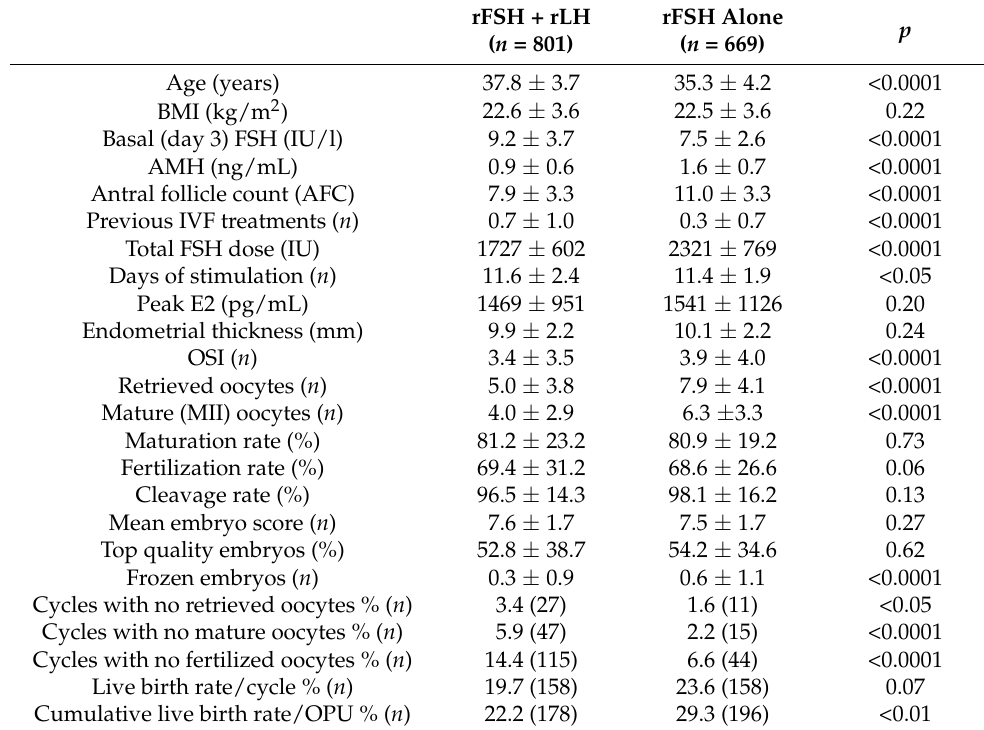
Table 1. Clinical baseline characteristics and IVF outcome of the overall patients’ population ( n = 1470) receiving COS with rFSH + rLH ( n = 801) or rFSH alone ( n = 669). Data are expressed as mean ± standard deviation or as absolute values and percentage, as